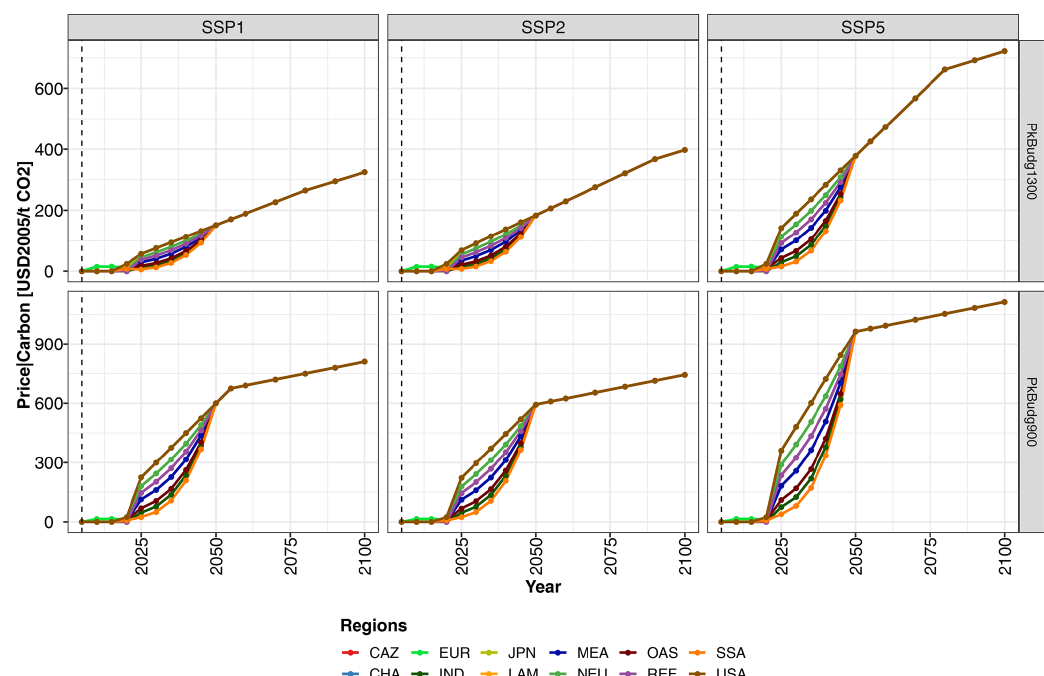
Figure 4. Regional CO 2 price trajectories for the NPi and PkBudg900 scenarios for SSP1, SSP2, and